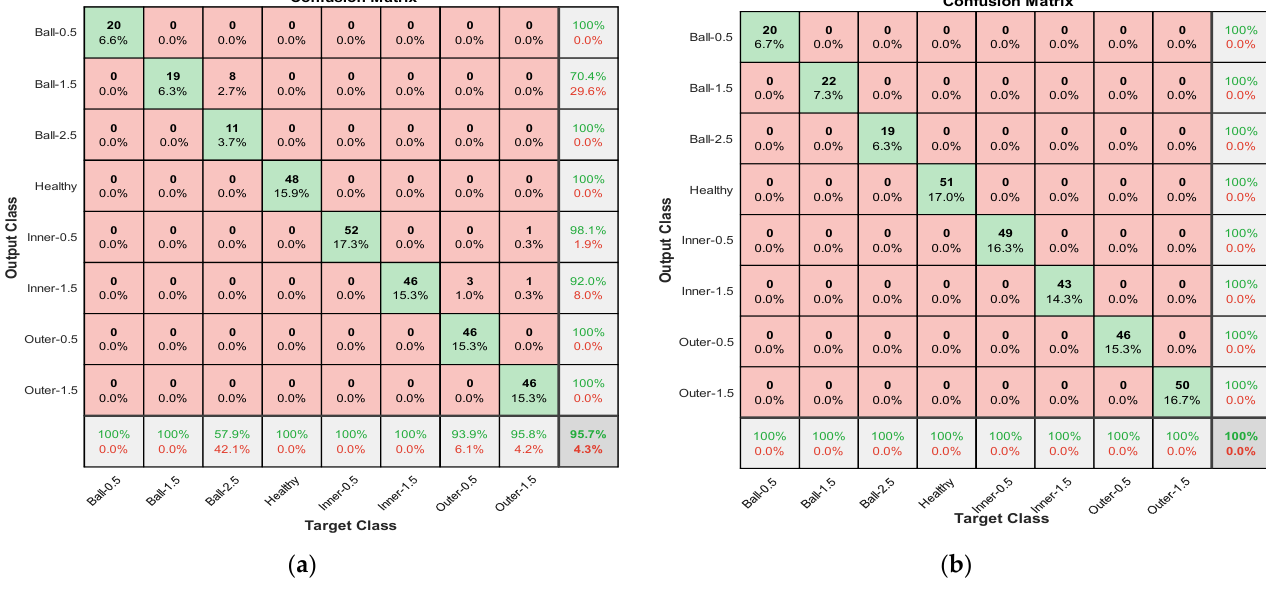
Figure 9. The two confusion matrices belonging to ( a ) GoogleNet and ( b ) AlexNet when the proposed data fusion is applied to all of the available sensors.